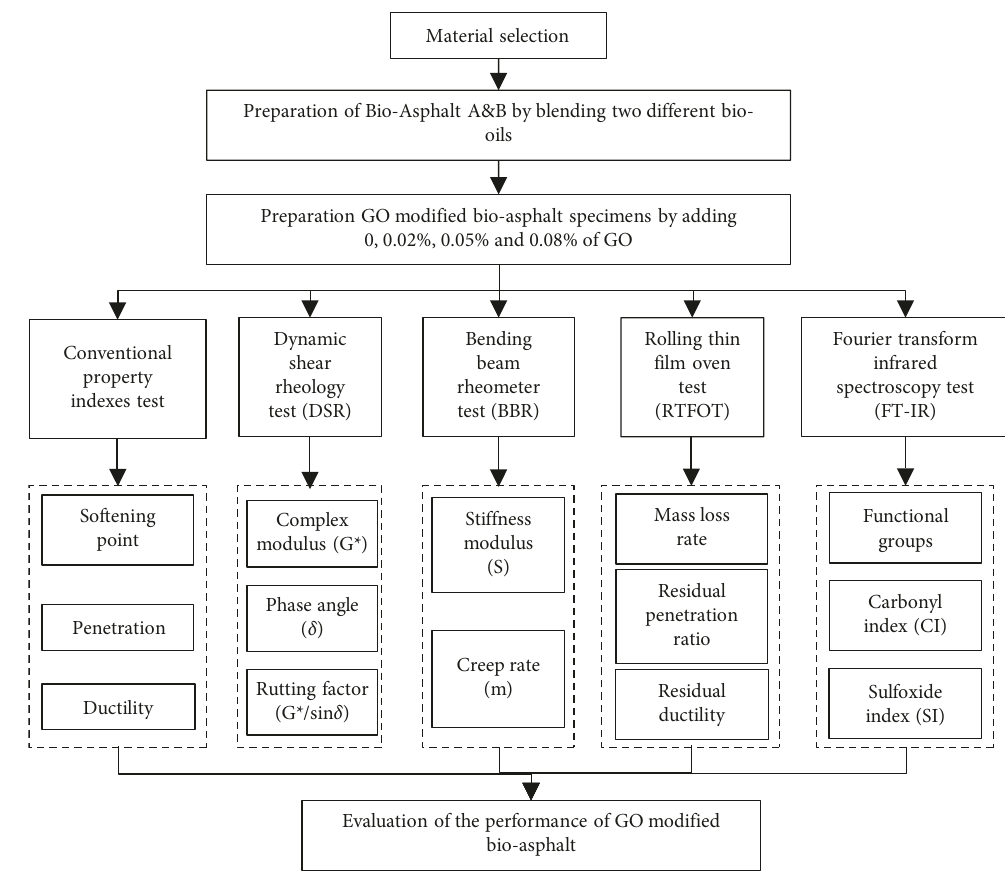
Figure 1: The flowchart of this study. Table 1: Performance indexes of the base